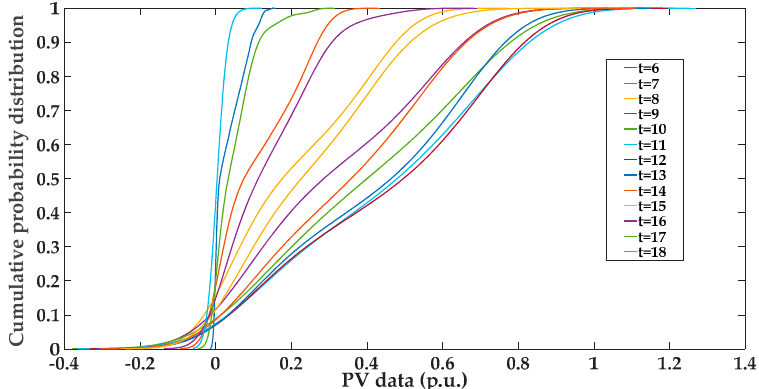
Figure 4. Cumulative probability functions of PV data during the times of t=6-18. Energies 2019 , 10 , x FOR PEER REVIEW